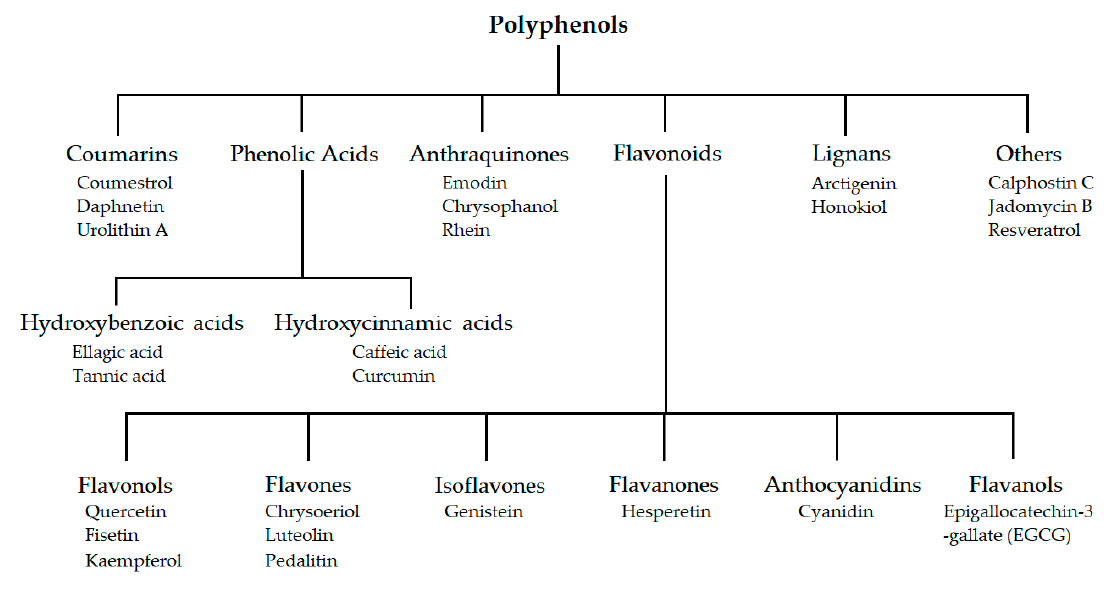
Figure 2. Classification of polyphenolic compounds.